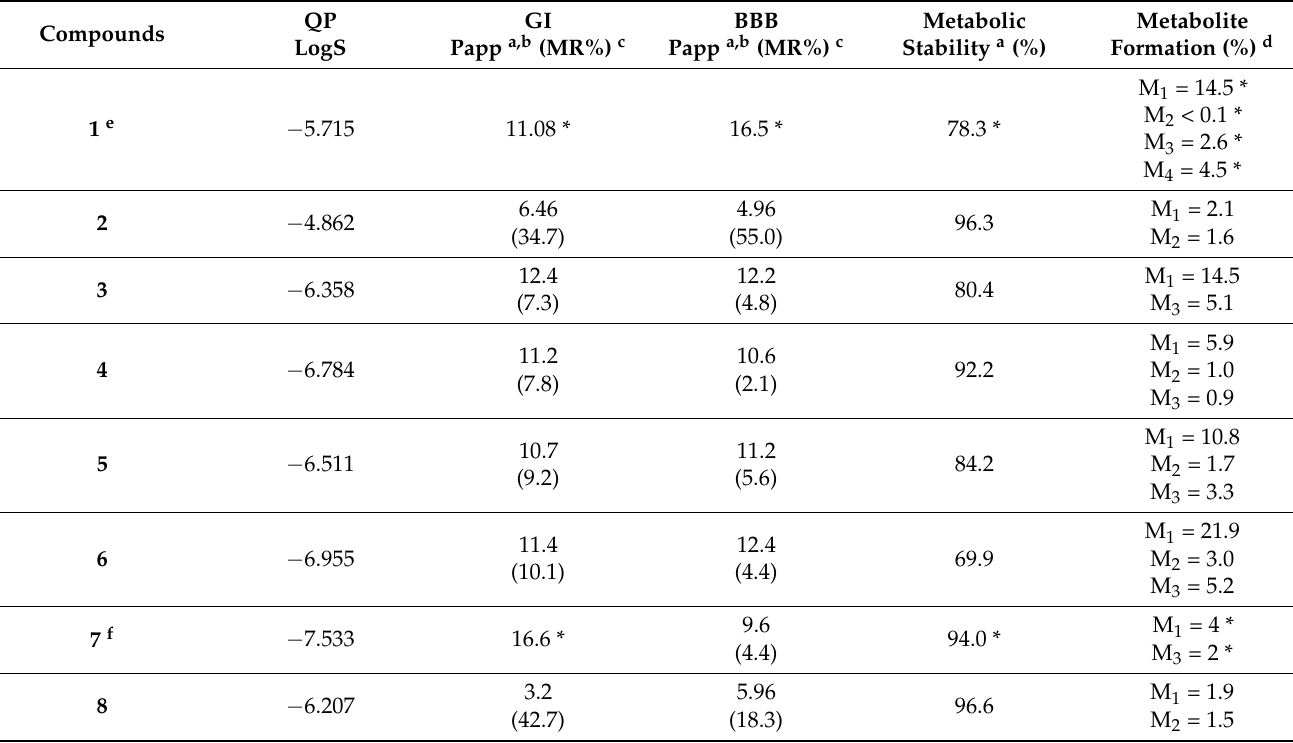
Table 3. In silico and in vitro ADME properties of compounds 1 – 12